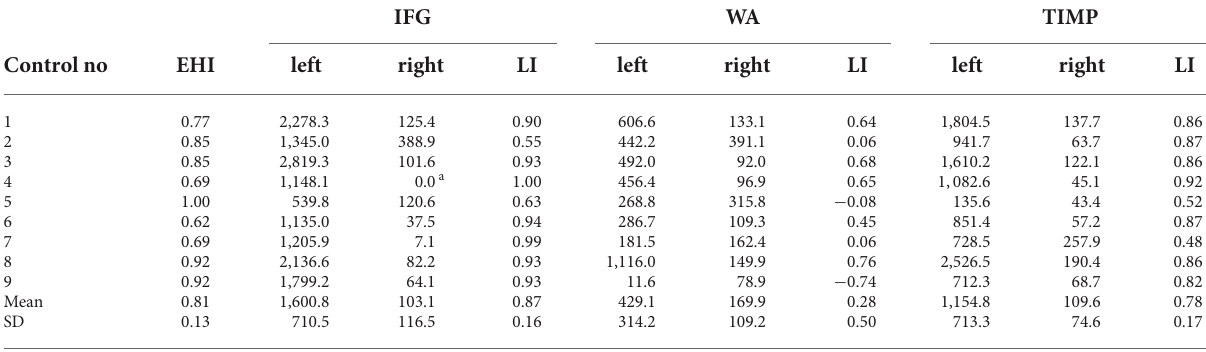
Left/right, sum of threshold surviving t -values per left and right ROI. a No voxels survived threshold in right ROI, i.e., the sum of thresholded t -values equals 0.0; EHI, Edinburgh Handedness Inventory; IFG, inferior frontal gyrus, WA, Wernicke Area; TIMP, temporal inferior and medial lobes plus temporal poles; LI, laterality index; left, sum of left t -values; right, sum of right t -values.